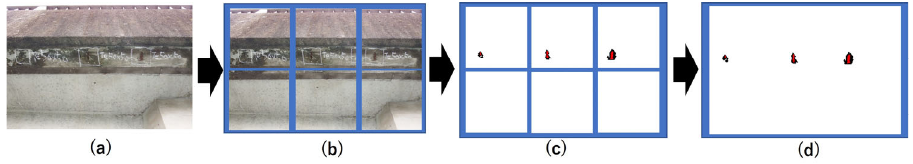
Figure 7. Example of the input and output of the image segmentation model. ( a ) Input image, ( b )